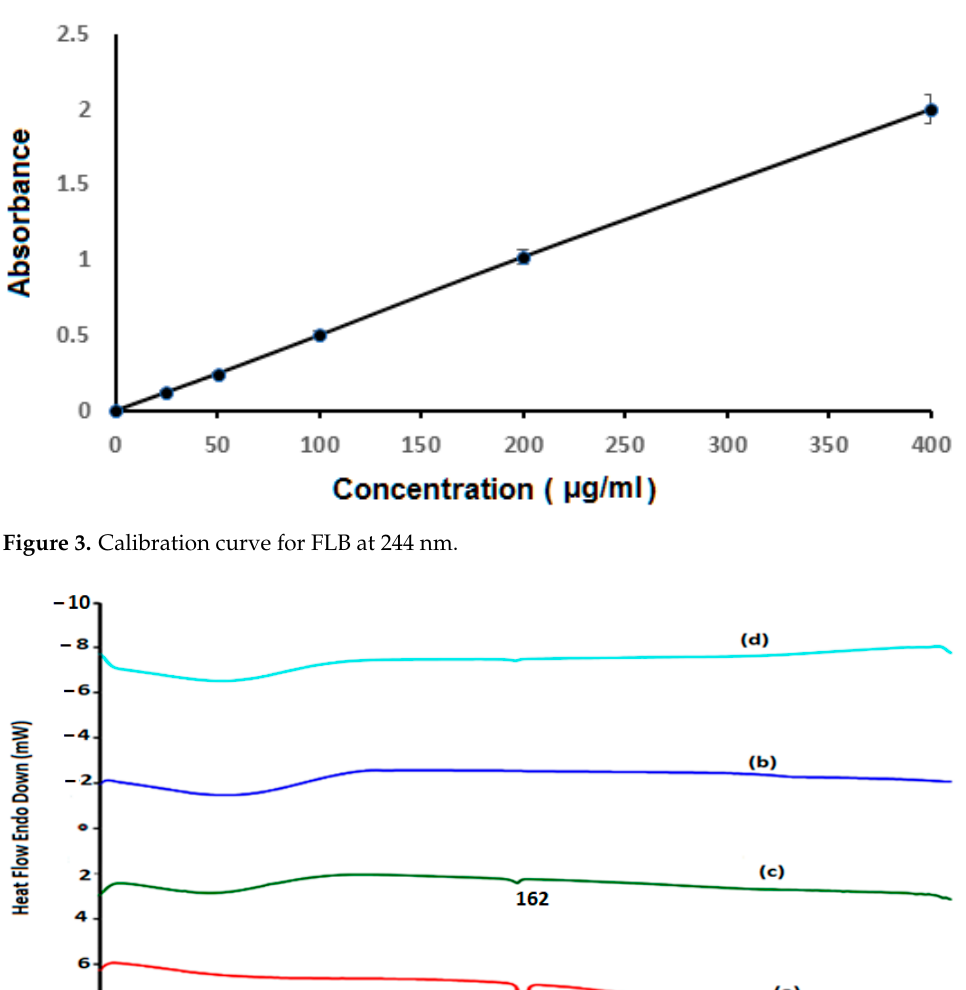
Figure 3. Calibration curve for FLB at 244 nm.